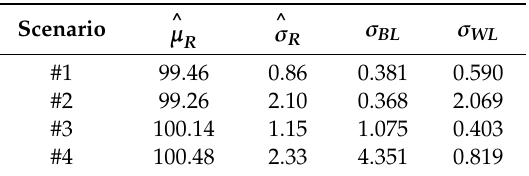
Table 2. Values of the mean and standard deviation for the reference product obtained by the simulation data set under di ff erent scenarios.